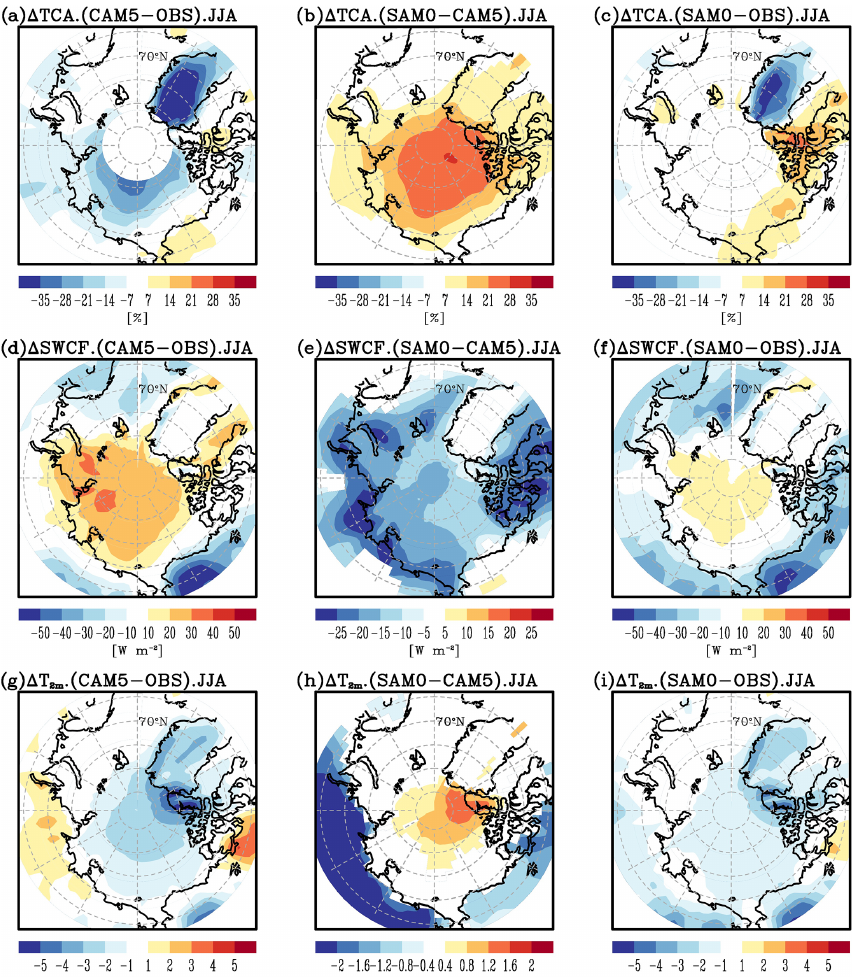
Figure 10. Identical to Fig. 8, except for total cloud fraction (TCA) in (a) , (b) , and (c) ; the SW cloud radiative forcing at TOA (SWCF) in (d) , (e) , and (f) and during